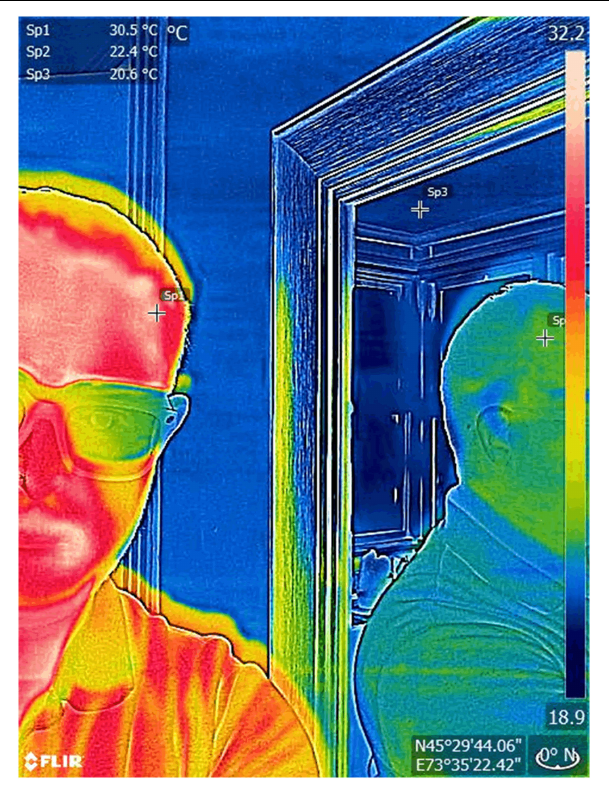
FIGURE 1 | Reflectivity and thermal imaging. The human skin behaves almost like a blackbody with emissivity ranges close to 100%. Thus, this tissue is ideally suited for infrared thermal imaging because the surrounding infrared radiation is absorbed and the output that the camera images and measures correspond almost entirely to the radiation the skin is emitting. In contrast when imaging a reflective surface such as a mirror with an index close to 0%, it is practically impossible to differentiate the radiation emitted by the object and the surrounding radiation scattered by it. In the image above, it can be seen how the skin thermal output (Sp1) can also be seen in a mirror, and how its measurement (Sp2) differs from the output of the surrounding structures (Sp3). Also, note how glasses, despite being transparent for visible light are not under IR. Images, courtesy of JR-G, were acquired using a FLIR One Pro